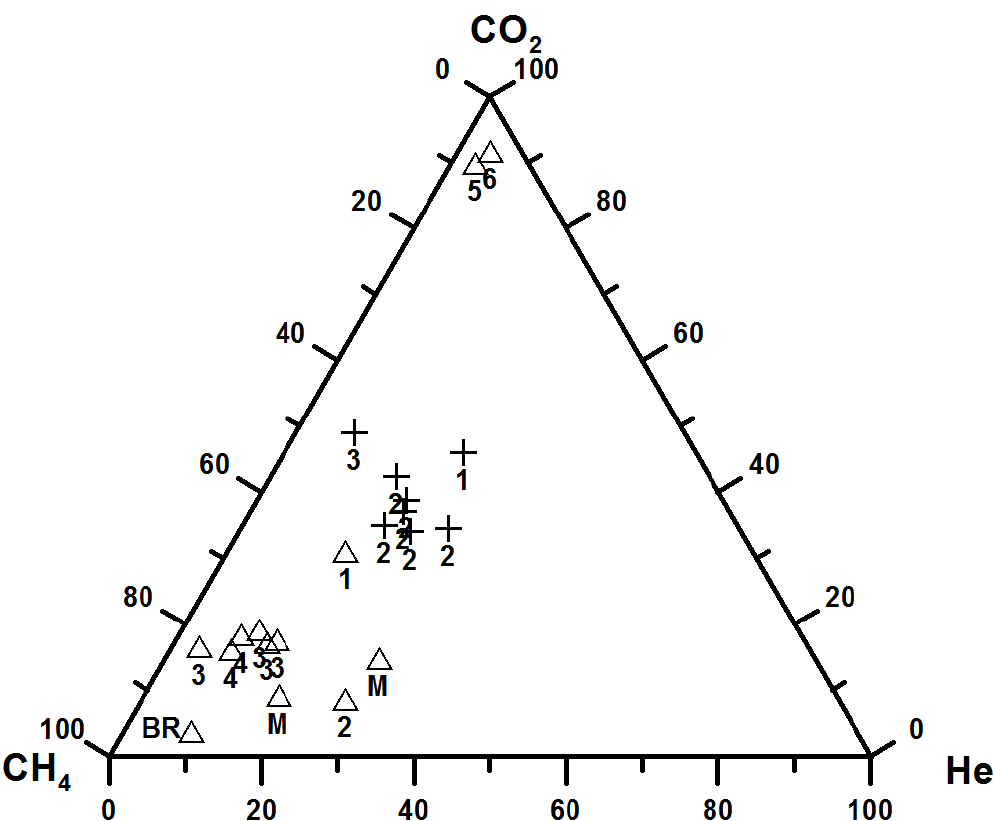
and CH for both bubbling (crosses) and dis- 2 4